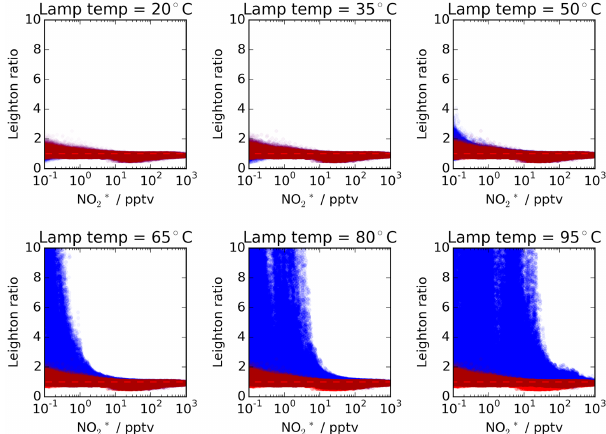
Figure 10. Leighton ratio calculated for each surface model grid- box for each daylight hour for March by the GEOS-Chem model as a function of the grid box NO 2 concentration. The instrument in- terference is characterized by a numerical solution of Eq. (5) with τ = 0 . 42s and a residence time of 1s. Red shows the values calcu- lated without the interference on the NO 2 concentration and blue indicates the values calculated with the interference. The interfer- ences are calculated for different lamp temperatures, 20 to 95 ◦